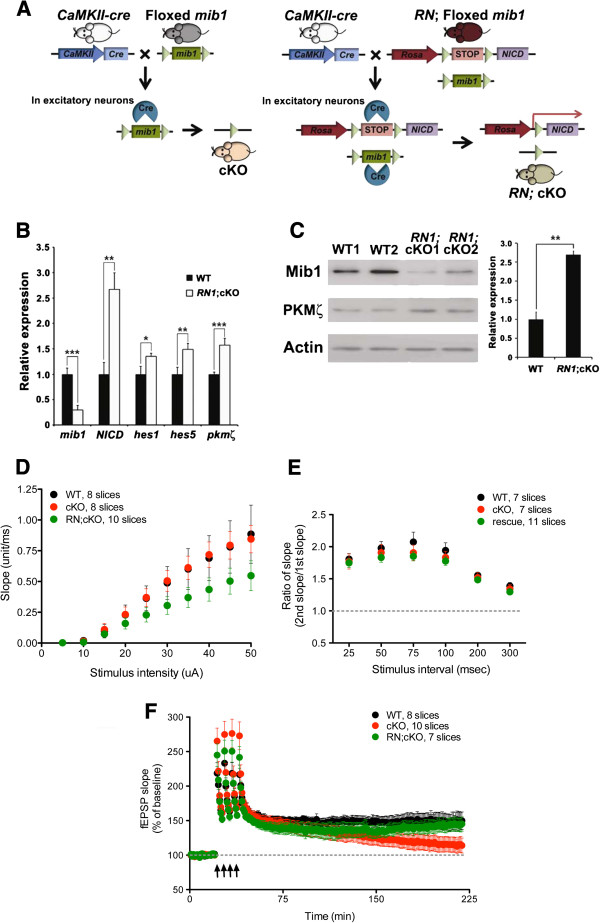
Introduction of Notch1 ICD rescues the phenotypes of mib1 cKO mice. (A) Schematic drawing of mouse breeding. RN1;mib1 cKO mice were generated by crossing CaMKII-cre/+;mib1f/f mice with the Rosa-Notch1/+; mib1f/f mice. (B, C) Increased pkmζ and Notch target genes in the RN1;mib1 cKO mice. Total RNA and protein lysates from the hippocampus of 4-month-old wild-type (n = 4) and RN1;mib1 cKO mice (n = 4) were analyzed by quantitative real-time PCR (left panel) (B) and by western blotting (C). PKMζ protein levels were quantified by densitometry (right panel). (D) Normal synaptic transmission in mib1 cKO and RN1;mib1 cKO mice. The synaptic input–output relationship was obtained by plotting the initial slope against the stimulus intensity (n = 8 for WT, n = 8 for cKO, n = 10 for RN1;mib1 cKO). (E) Normal paired-pulse response ratio in mib1 cKO and RN;mib1 cKO mice. The graph depicts the paired-pulse response ratio (2nd fEPSP/1st fEPSP) obtained at different interstimulus intervals (n = 7 for WT, n = 7 for cKO, n = 11 for RN1;mib1 cKO). (F) L-LTP is totally recovered in RN;mib1 cKO mice compared to mib1 cKO mice (n = 8 for WT, n = 10 for cKO, n = 7 for RN1;cKO).